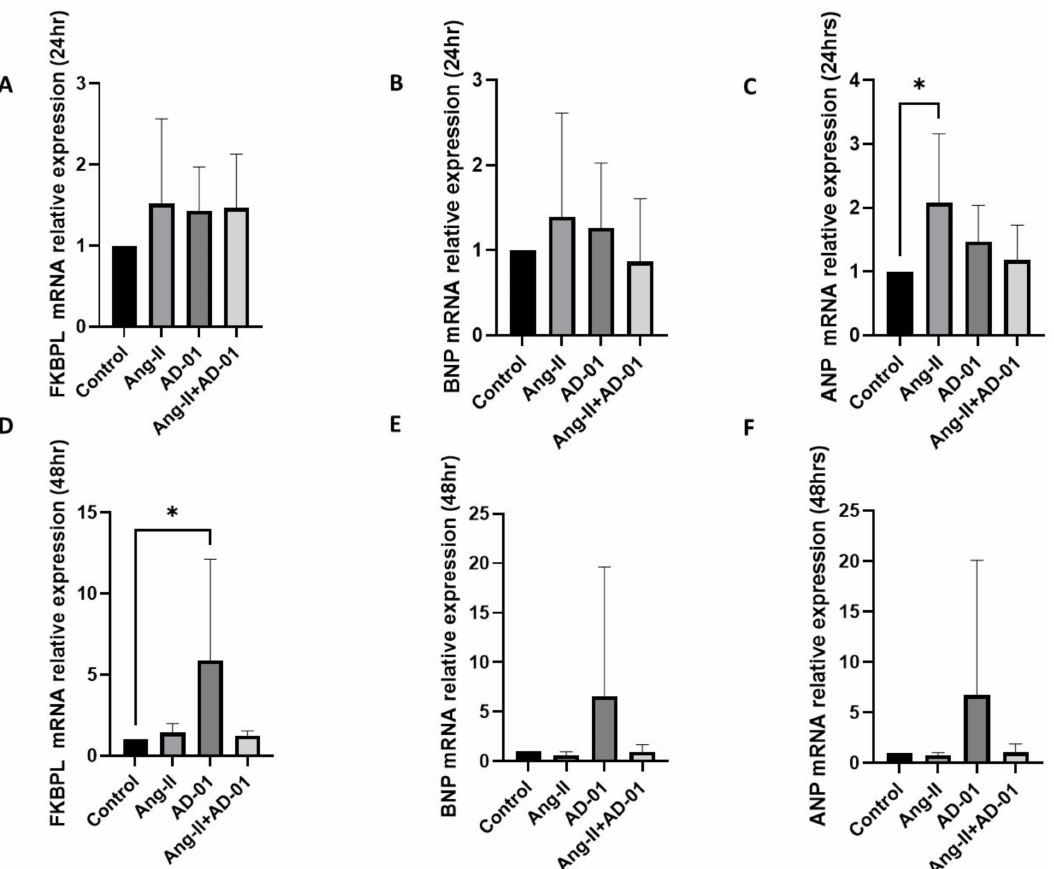
Figure 2. H9C2 cardiomyocyte mRNA expression of FKBPL, BNP and ANP following Ang-II and/or AD-01 treatment. H9C2 cells were exposed to treatment groups (i) Ang-II (100 nM), (ii) AD-01 (100 nM) and (iii) Ang-II (100 nM) + AD-01 (100 nM) for 24 or 48 h before RNA lysates were collected and qPCR performed. ( A ) FKBPL mRNA expression at 24 h; ( B ) BNP mRNA expression at 24 h; ( C ) ANP mRNA expression at 24 h; ( D ) FKBPL mRNA expression at 48 h; ( E ) BNP mRNA expression at 48 h; ( F ) ANP mRNA expression at 48 h. Results expressed as Mean ± SEM ( n ≥ 4), One-way ANOVA with Tukey’s post-hoc. * p < 0.05. Ang-II—angiotensin II; AD-01—FKBPL-based therapeutic